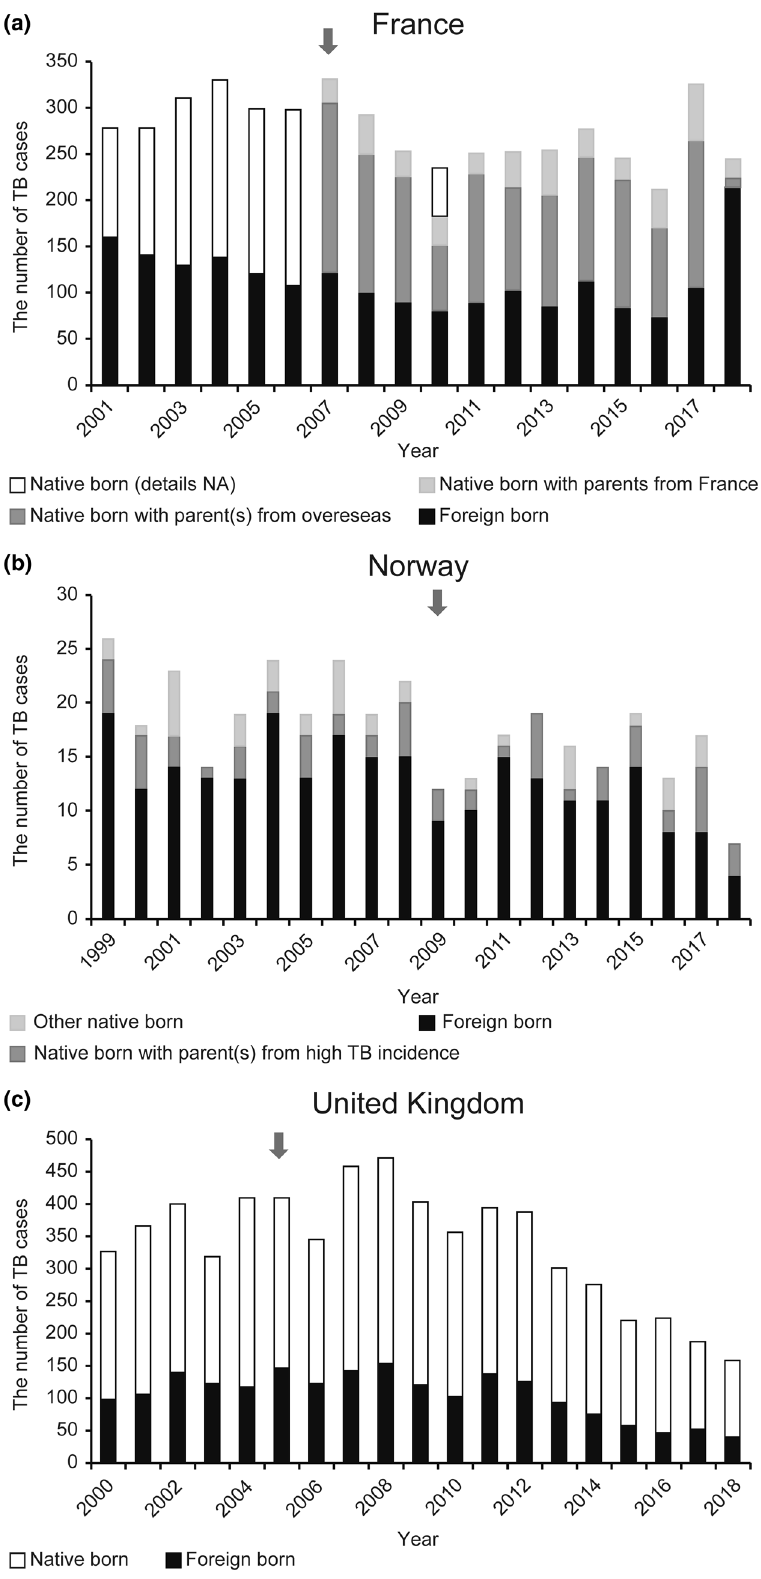
Figure 2. Birthplace-related characteristics among children with tuberculosis (0–14 years of age). *Data sources: Santé Publique France, Norwegian Institute of Public Health, and Public Health England. † The arrow shows the year of